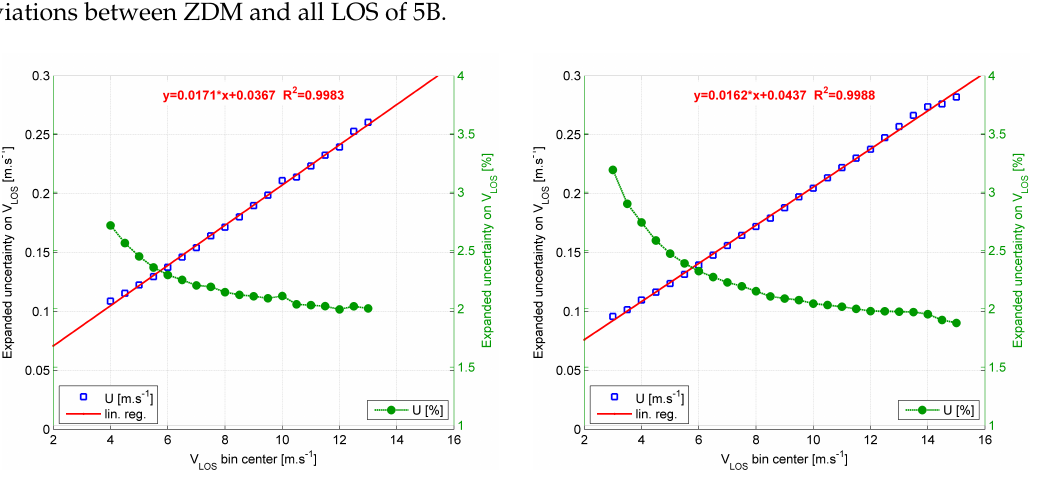
Figure 10. Expanded LOS velocity measurement uncertainties in m · s − 1 and in % of V LOS . Left : 5B; Right :